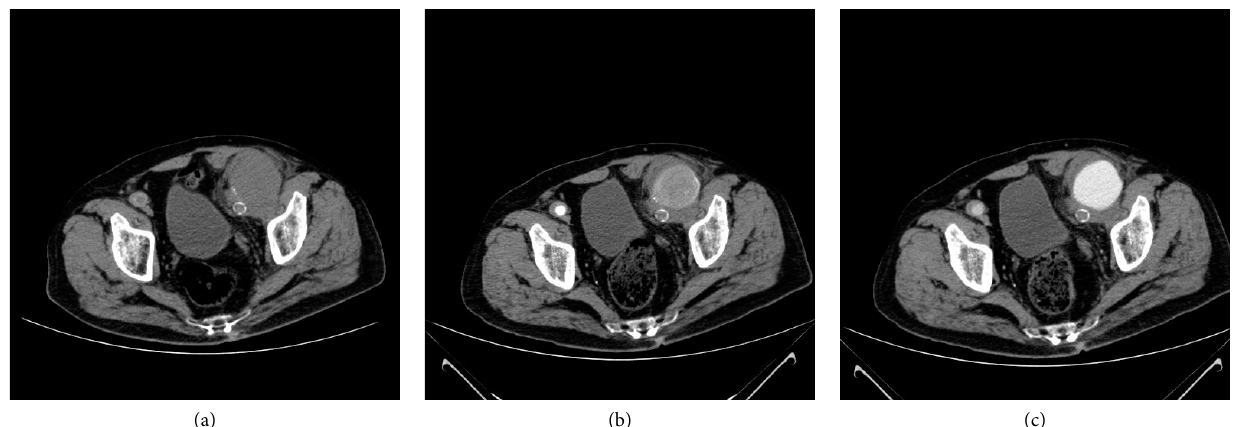
Figure 1: Same axial slice using a 64-detector row CT scanner (a) before and (b) & (c) after contrast media injection (arterial and portal phase respectively), revealing a ruptured left femoral pseudoaneurysm at the distal end of the left limb of the aortobifemoral graft.